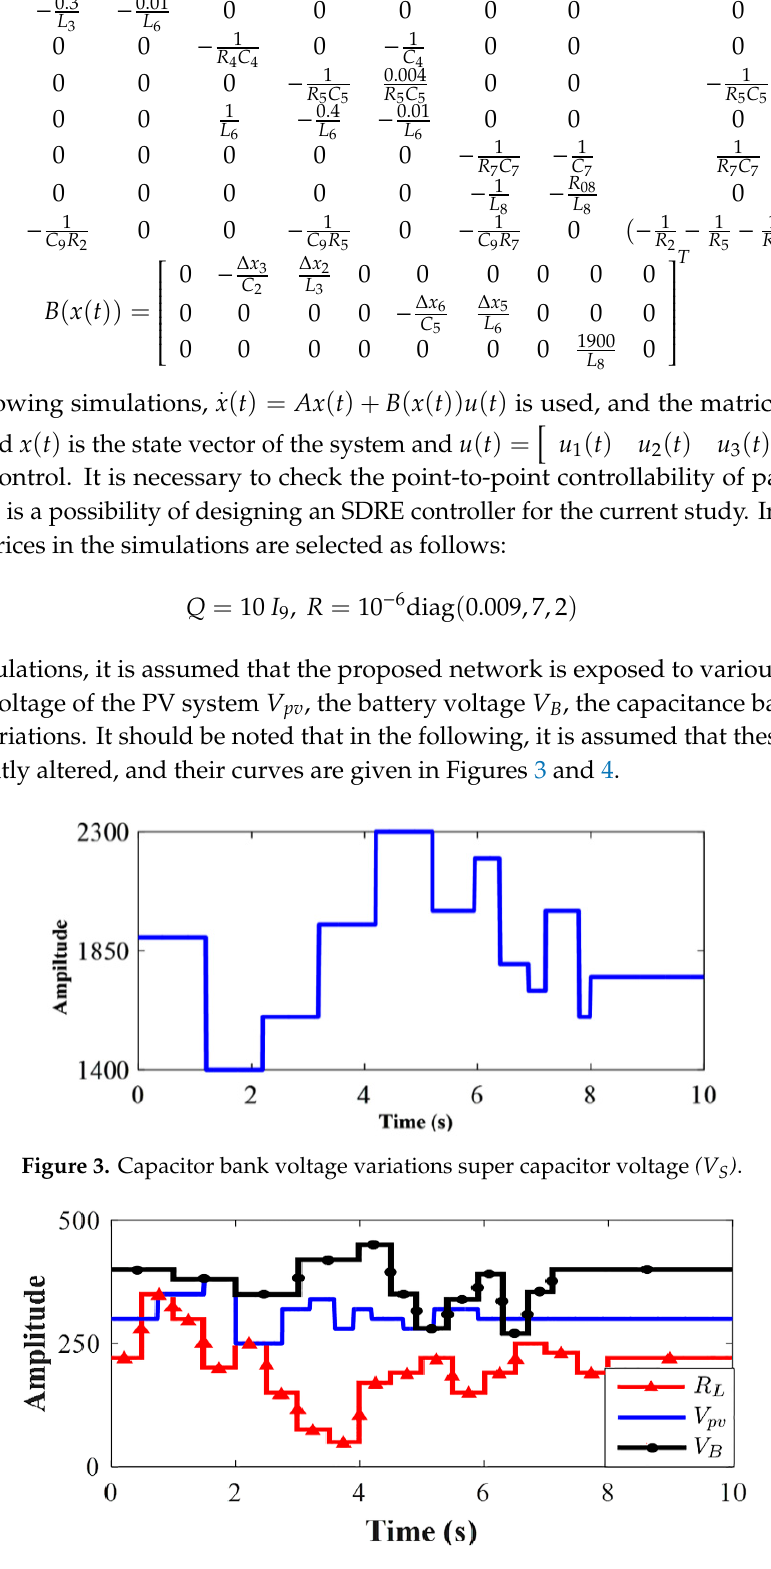
Figure 4. PV voltage (Vpv) battery storage voltage ( V B ) and load variation.